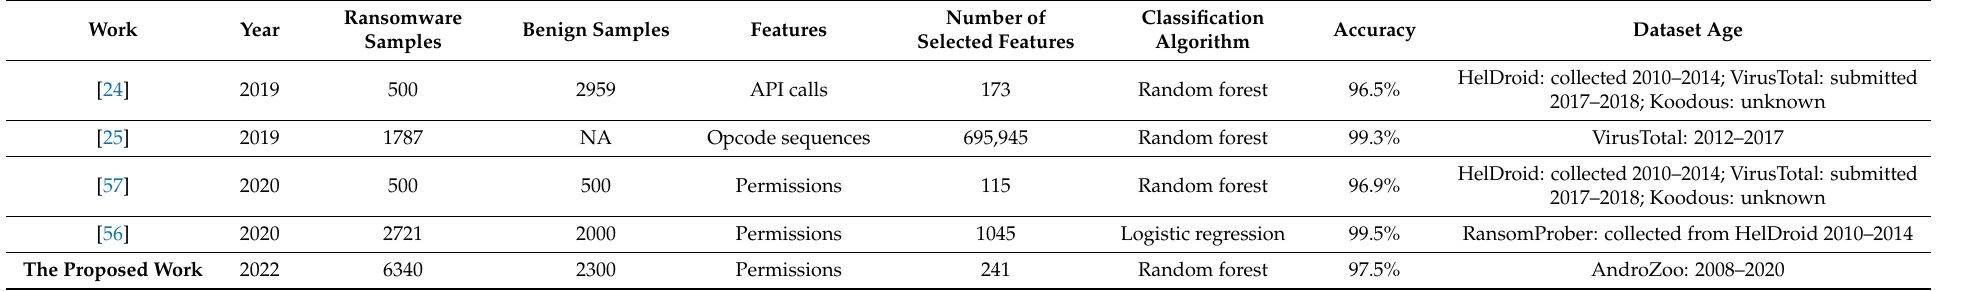
Table 9. A comparison between the recent state-of-the-art works and the proposed